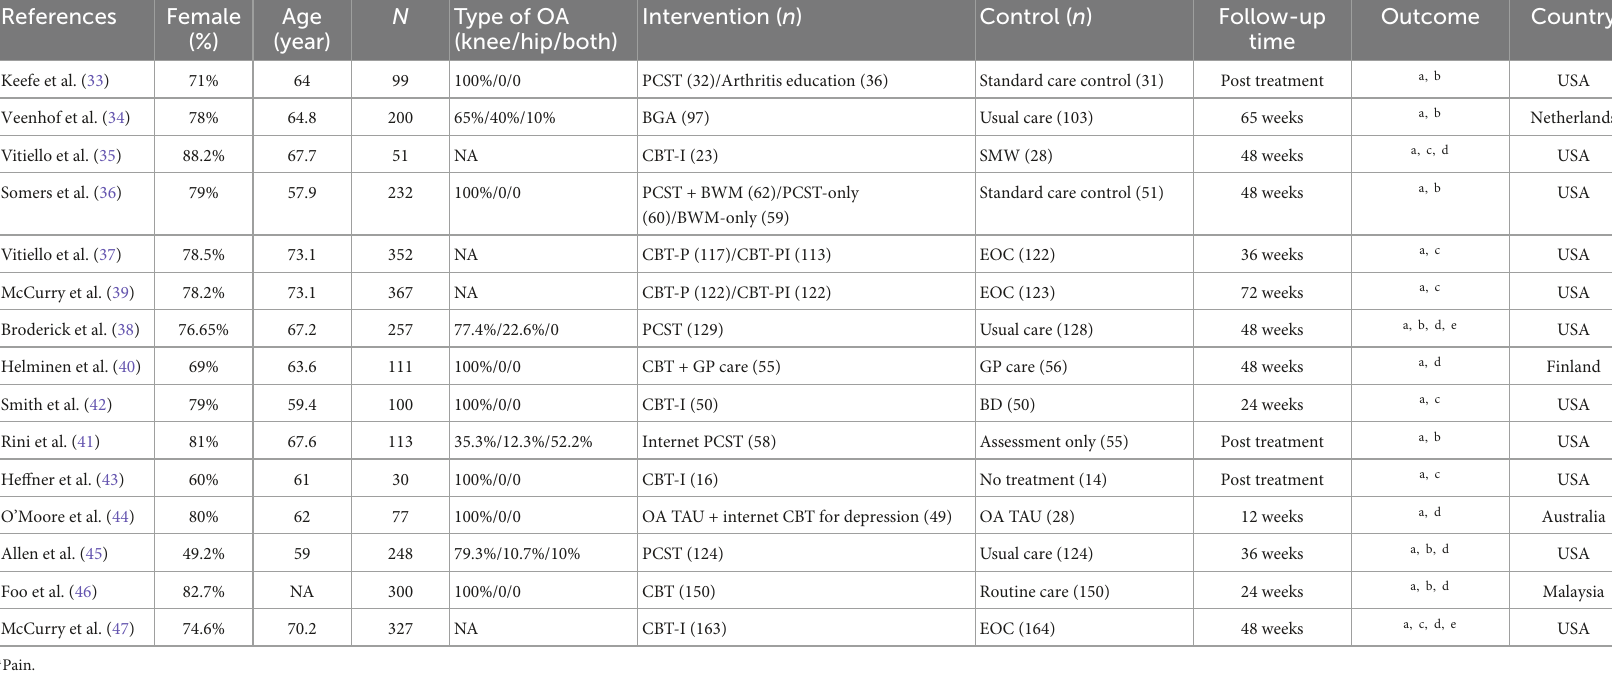
TABLE 1 Characteristics of included studies ( n =